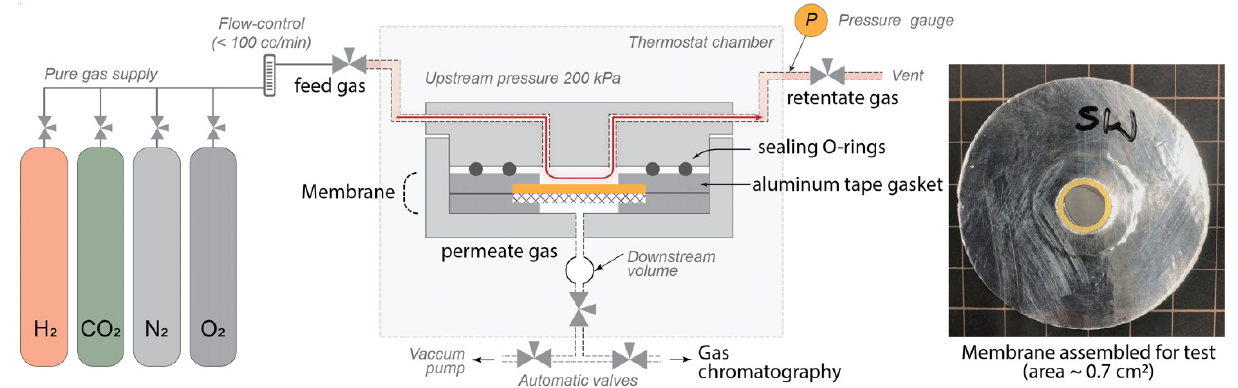
Figure 1. Schematic illustration of the gas permeability measurement setup. Photography shows the membrane prepared for the gas permeability testing—the small membrane area in the middle is exposed to the compressed gas in the GTR- 31A system.